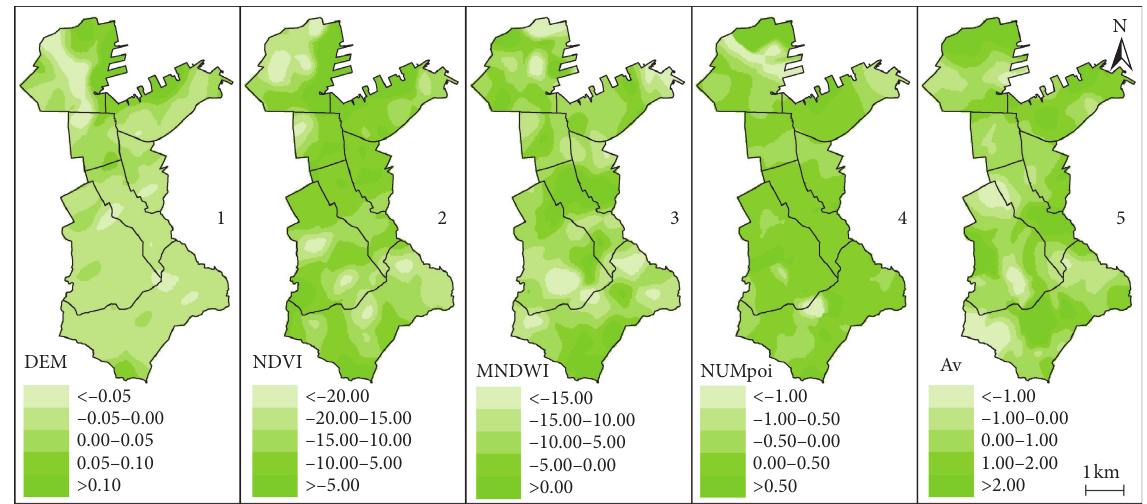
Figure 4: Regression factor coefficients. DEM, digital elevation model; NDVI, normalized difference vegetation index; MNDWI, modified normalized difference water index (MNDWI); NUM POI , point-of-interest number; A v , building-coverage ratio.